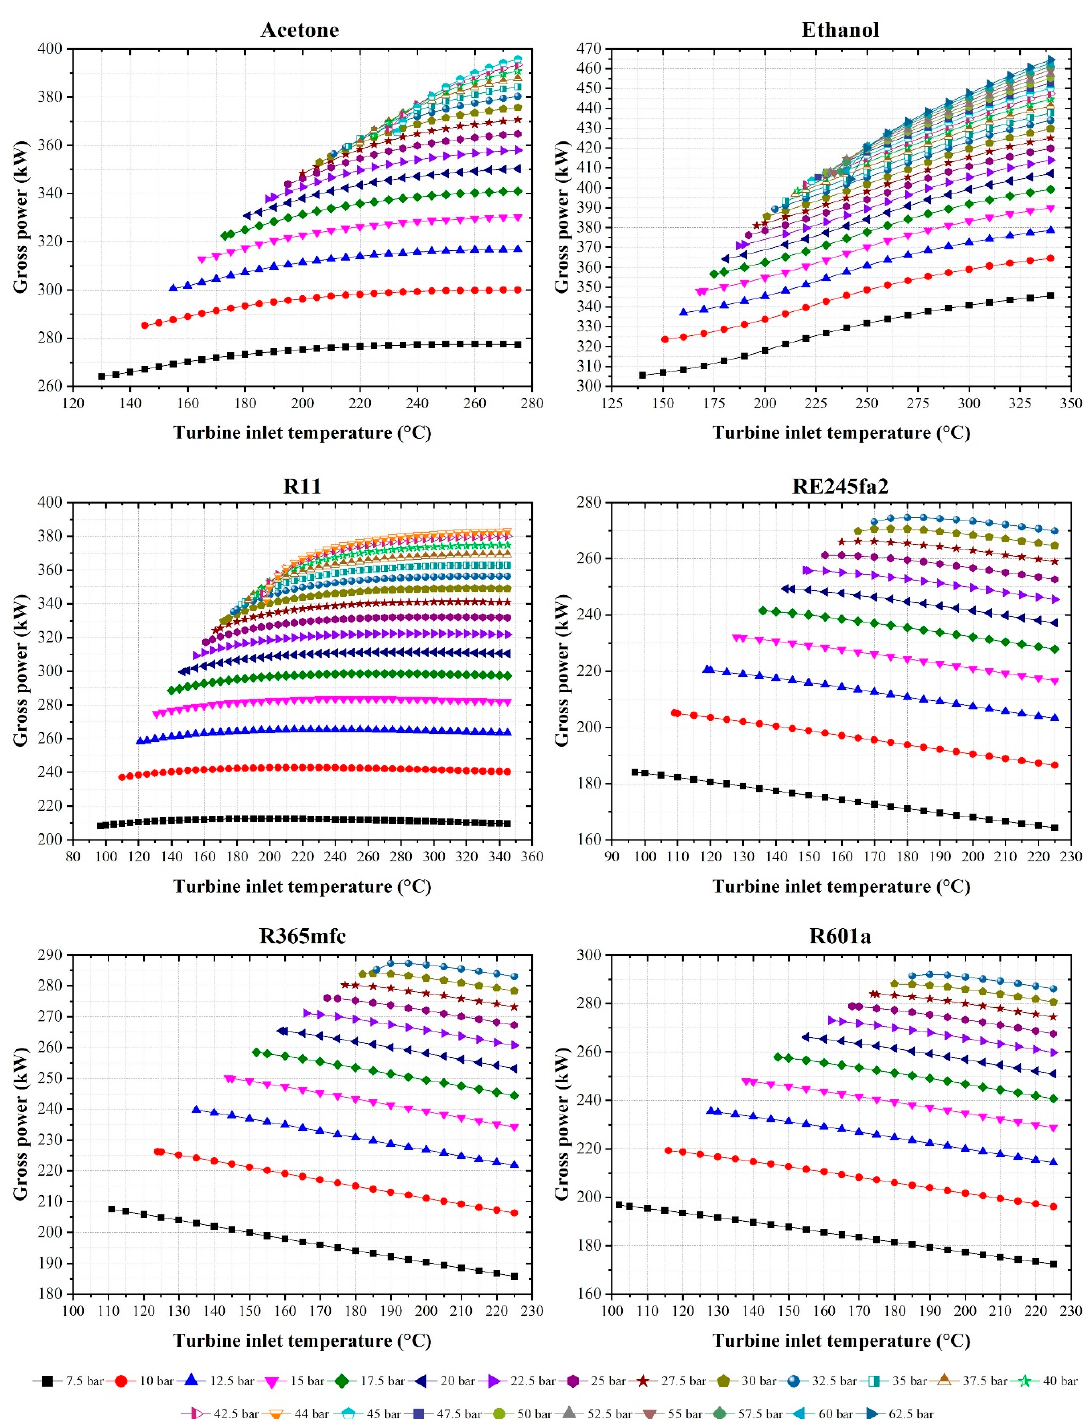
Figure 4. The gross power values calculated from the ORC turbine for varying turbine inlet temperatures and turbine inlet